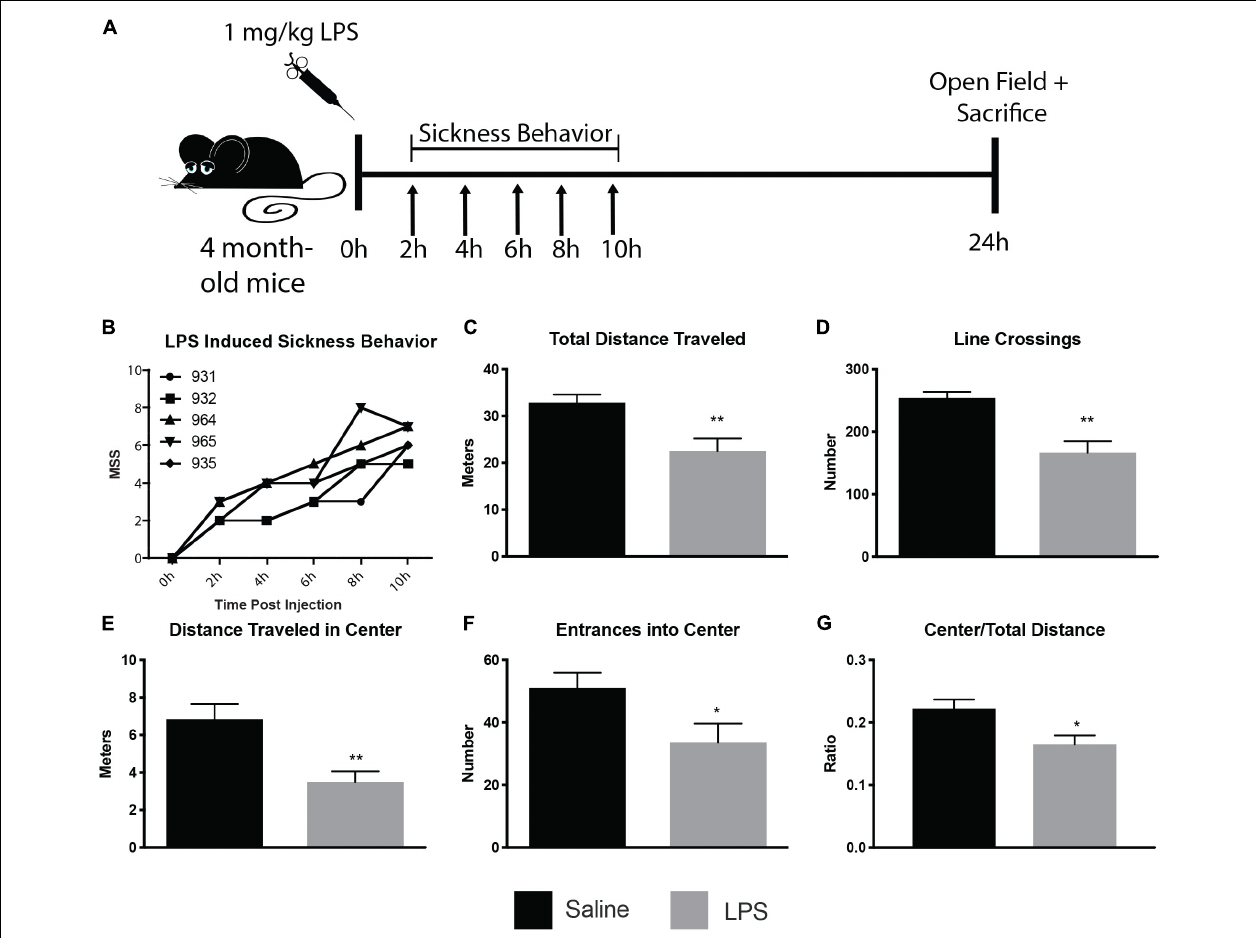
FIGURE 1 | LPS induced sickness behavior in 4 month old mice. Mice were injected with 1 mg/kg LPS or saline and assayed for sickness behavior, using the murine sickness score (MSS) tallied every 2 h for 10 h post-injection and open field behavior assay 24 h post-injection (A) . LPS-injected mice displayed increases in MSS (B) and decreases in total distance traveled (C) , line crossings (D) , distance traveled in the center (E) , entrances into center (F) , and center/total distance traveled (G) . ∗ p < 0.05, ∗∗ p < 0.01.